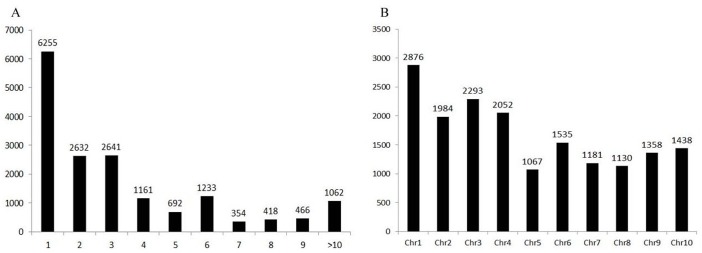
The distribution of indel loci in sorghum (A: the distribution of base differences, X axis is base difference, and Y axis is number; B: the distribution of indel in different chromosomes, X axis is chromosome, and Y axis is number).